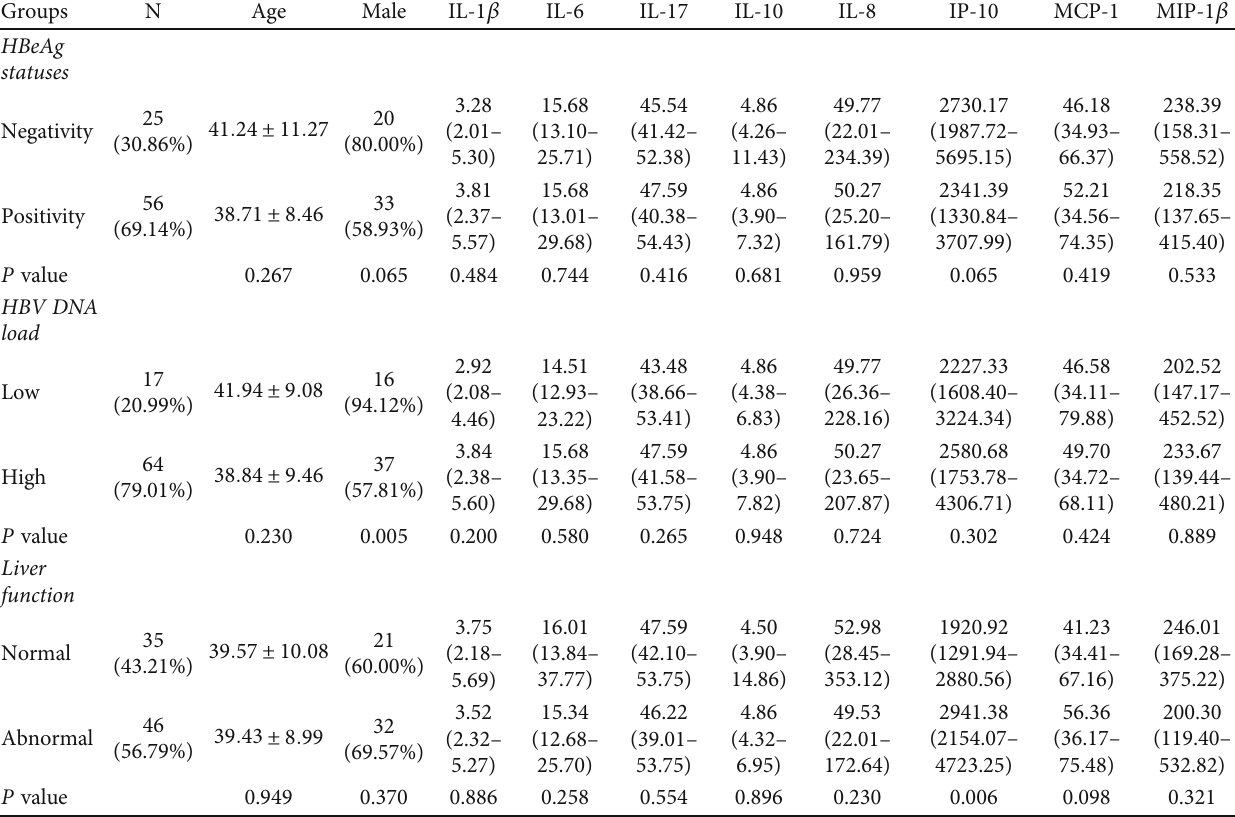
Table 4: Circulating cytokine and chemokine levels in chronic hepatitis B patients with di ff erent clinical characteristics. Groups